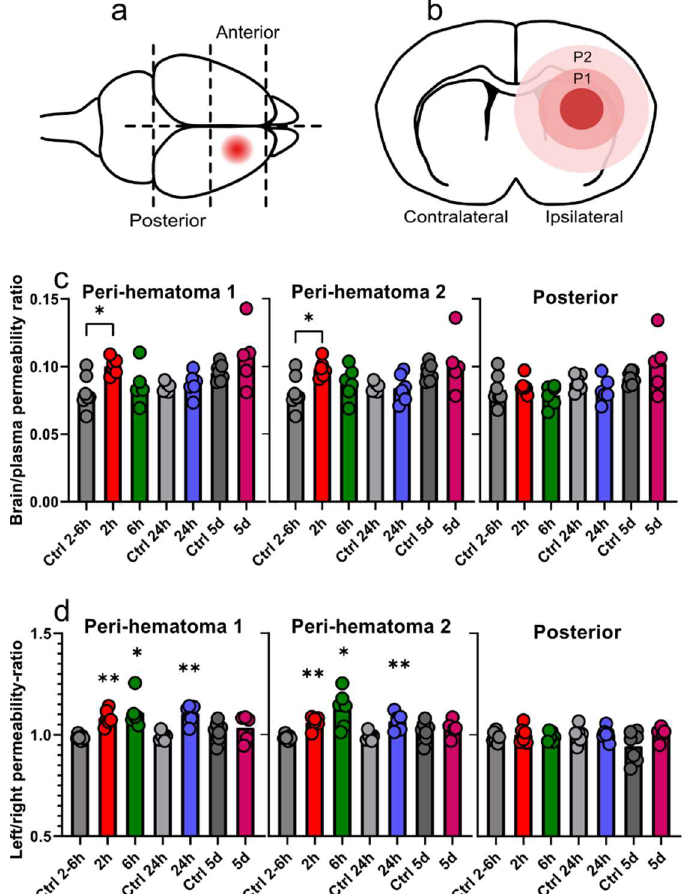
Figure 2. GMH induces spatial and temporal changes in BBB function. Regional BBB function was determined by sucrose permeability at different times after GMH. The regions of measurements are shown in ( a ) sagittal and ( b ) coronal (P1 = peri-hematoma 1, P2 = peri-hematoma 2). ( c ) The sucrose concentration ratios in the ipsilateral regions at 2 h, 6 h, 24 h and 5 days after GMH along with age-matched control animals. ( d ) The sucrose permeability concentration ratios between the ipsilateral and contralateral sides of the brain within animals. Unpaired t -tests and one-way ANOVA with Dunnett’s multiple comparison test ( c ), paired t -tests ( d ), * p ≤ 0.05, ** p ≤ 0.01. n = 7 (control groups) or 6 (GMH groups) per time-points, bar graphs represent mean